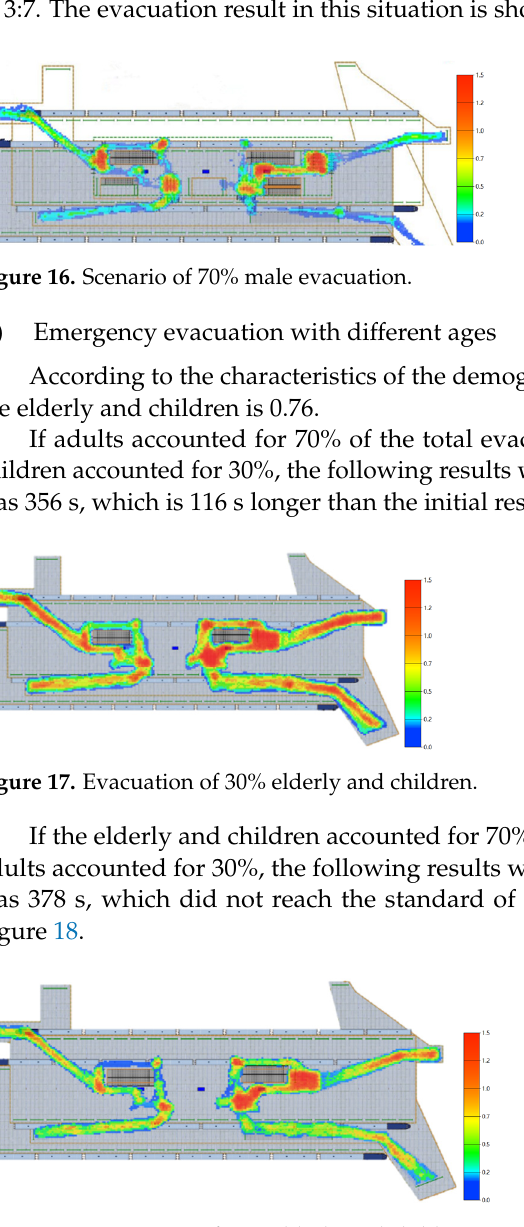
Figure 15. Scenario of 70% female evacuation.